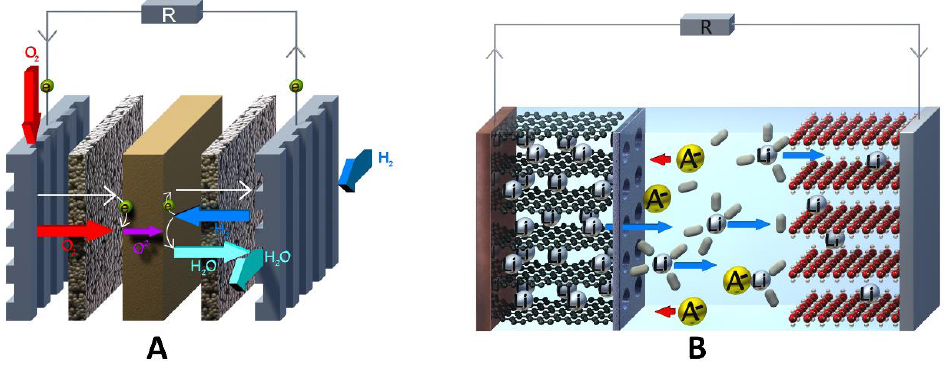
Figure 1. ( A ) Schematic of a hydrogen fuel cell with irreversible gas electrodes and ( B ) a lithium-ion battery